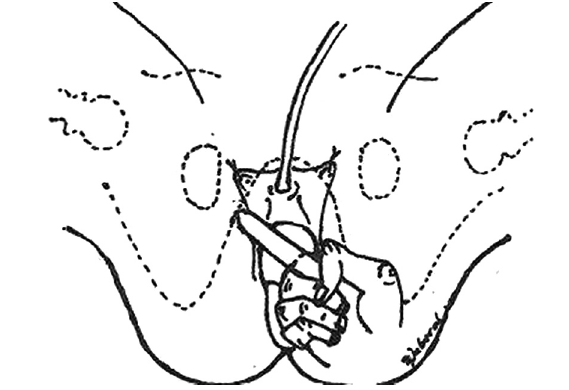
Figure 2 – Digital identification of the arcus tendineous fascia pelvis (ATFP).